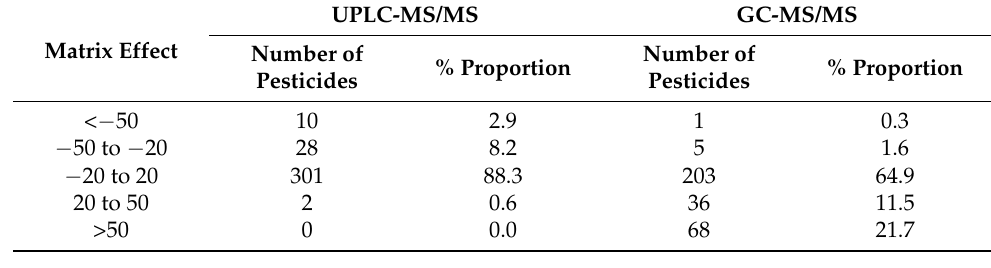
Table 2. Evaluation of matrix effect in UPLC-MS/MS and GC-MS/MS.